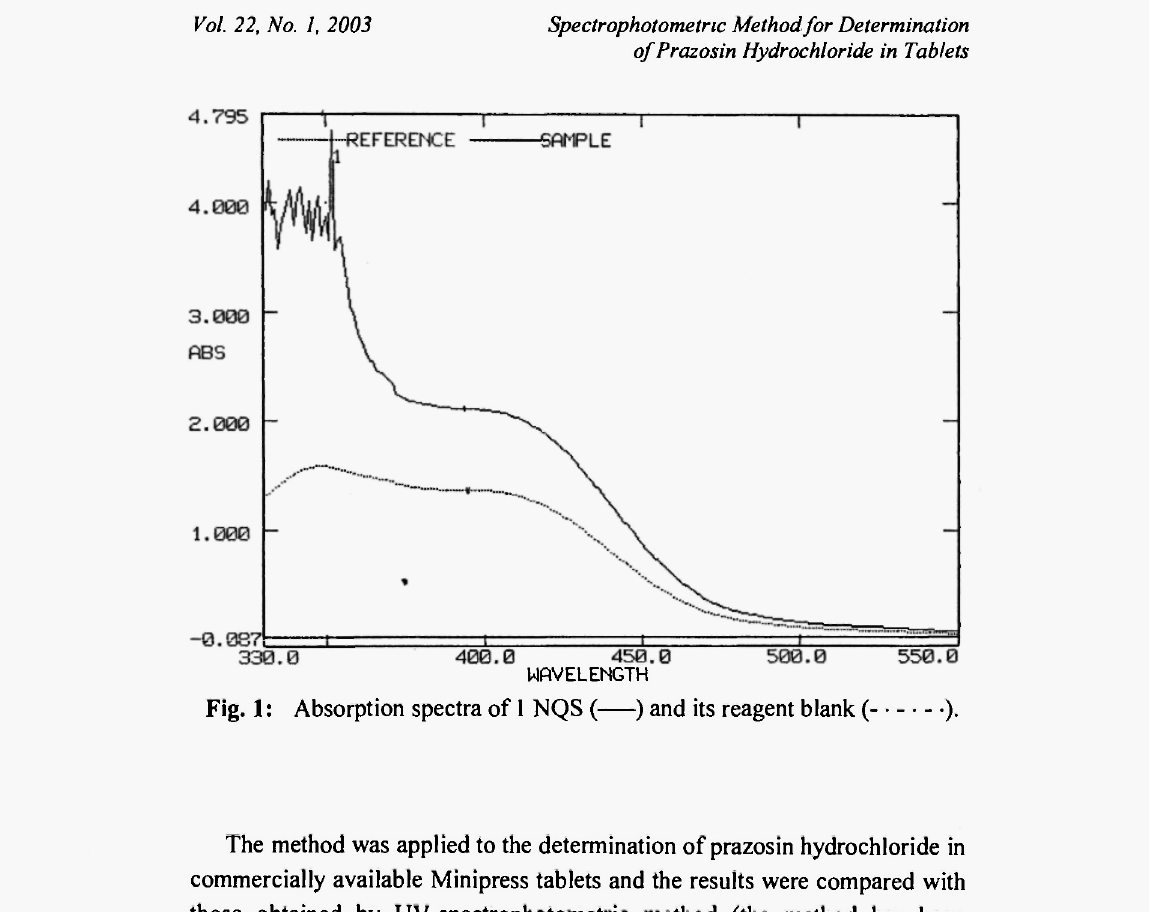
Fig. 1 : Absorption spectra of 1 NQS ( ) and its reagent blank (